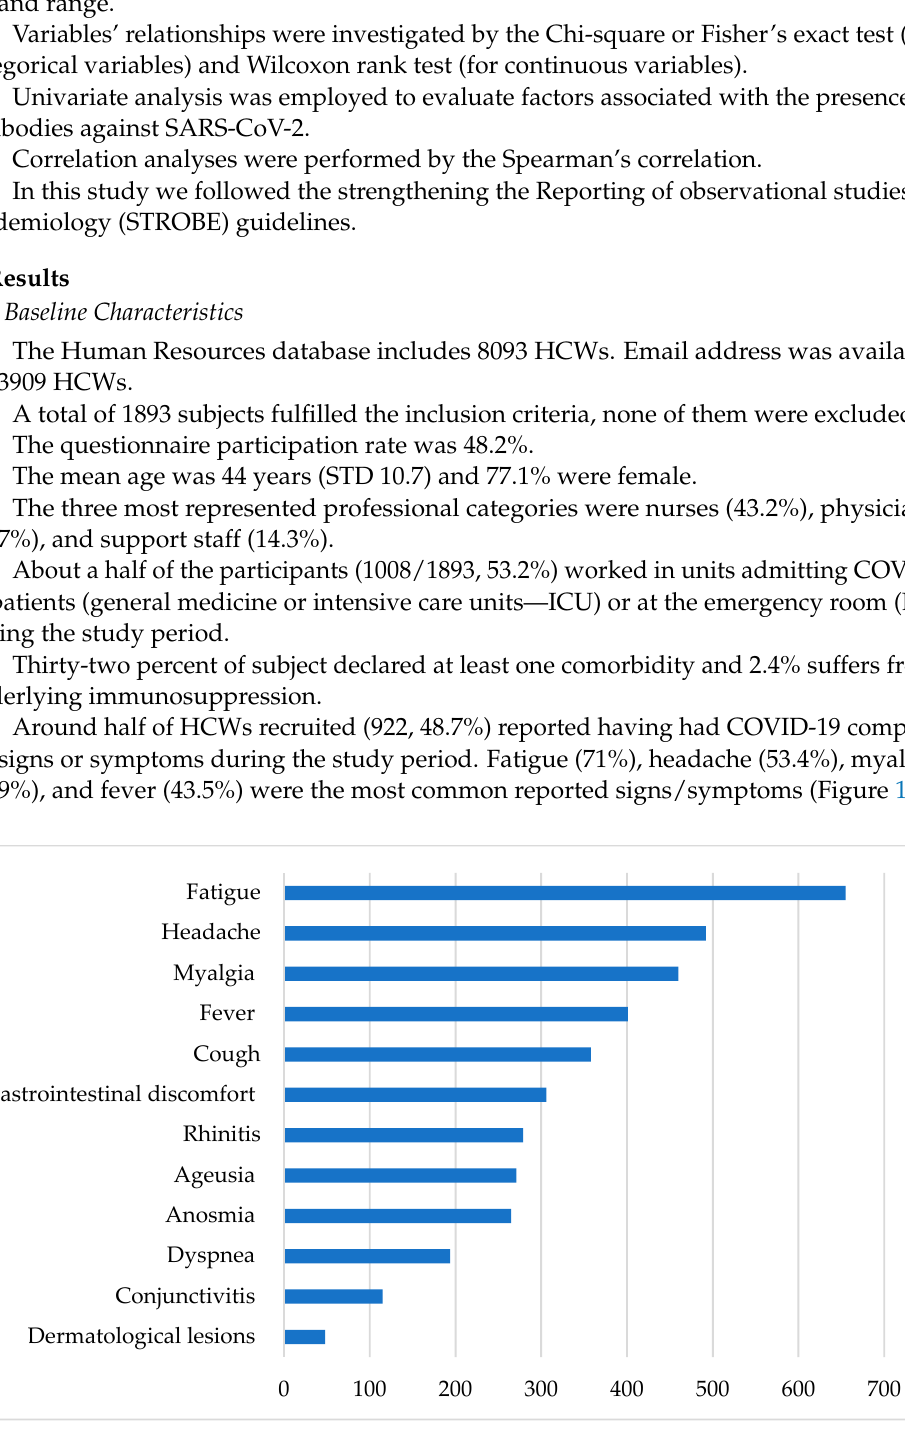
Figure 1. COVID-19 compatible signs and symptoms ( n = 922).